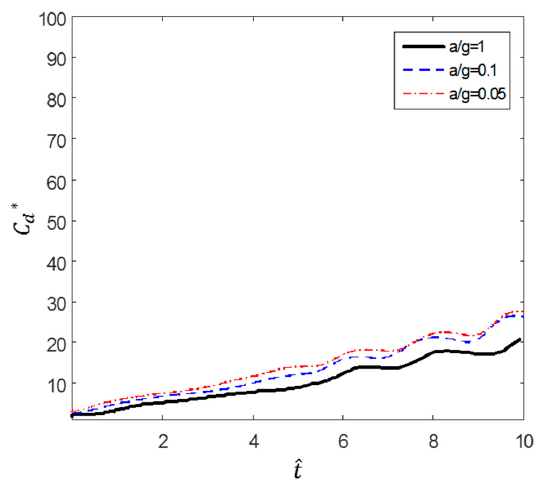
19 of 27 Figure 21. Comparison of drag coefficient 𝐶 (cid:3031) between non-accelerated flow (Bullivant [20]) and accelerated flow ( 𝑅𝑒 (cid:2868) = 1000 ) 4.2 Drag Changes over Dimensionless Time and Flow Time Figures 22 and 23 show the variations in 𝐶 (cid:3031)∗ and 𝐶 (cid:3031) , respectively, with 𝑡̂ . As mentioned earlier,